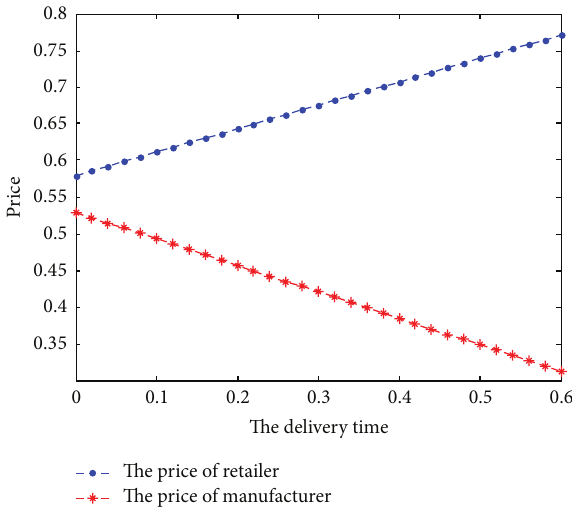
Figure 4: Effect of the delivery time on Nash equilibrium prices.